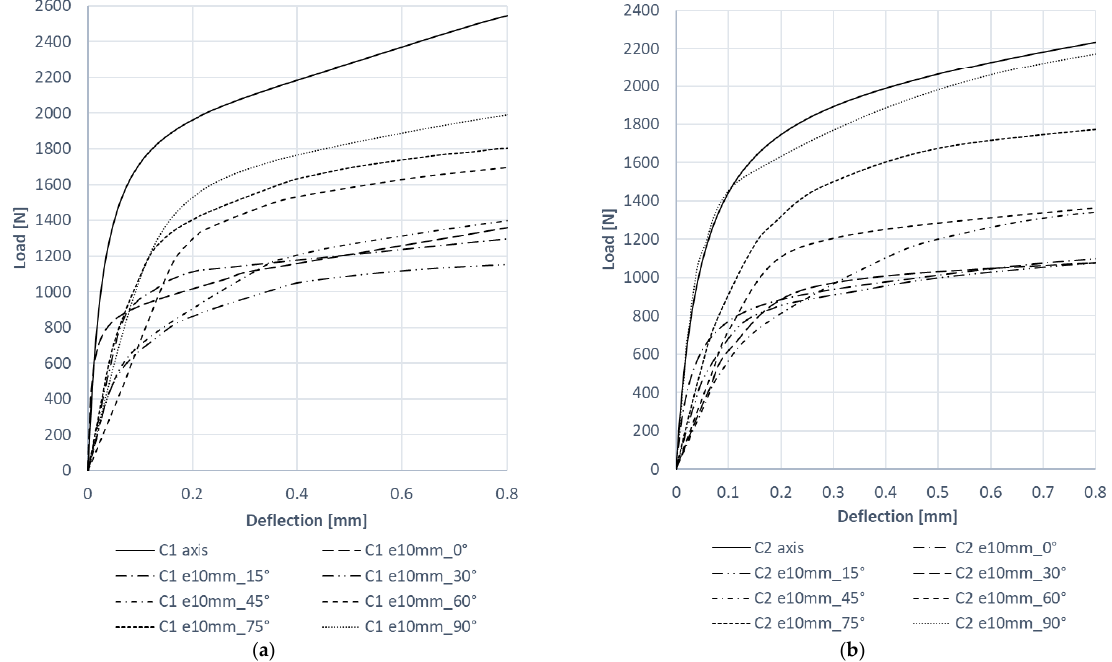
Figure 19. Load eccentricity versus postbuckling behavior for: ( a ) C1, ( b ) C2. The results demonstrate that the postbuckling stiffness of C1 and C2 decreased when eccentricity was applied. Regarding C1 (Figure 19a), the maximum decrease in the stiff- ness of this structure under eccentric load was observed for e10mm_30° and amounted to 57% (compared to the axial compression case). As for C2 (Figure 19b), the eccentricity of e10mm_0° caused the highest decrease in the column’s stiffness , of 52%. An analysis of the other cases tested demonstrated a 10% increase in the stiffness of C2 for the eccentricity value of e10mm_90°. The smallest decrease in the stiffness of eccentrically loaded C1 and C2 was observed for the eccentricity value of e10mm_90°. The high costs of producing carbon – epoxy composite profiles make tests of this type expensive. This is a major limitation for scientists who research this type of structure. It should be added that FEM modelling may be interesting for considering the progressive failure and failure processes in composites [58 – 65]. For this reason, future research direc- tions will focus on the analysis of the post-critical state in the full range of loads leading to the damage and failure of the composite structure. 5. Conclusions This study investigated the effect of compressive load eccentricity on the stability and postbuckling behavior of thin-walled composite channel columns. A combined qualita- tive and quantitative analysis of the effect of the compressive load eccentricity on critical loads and postbuckling equilibrium paths of these structures was performed. The results demonstrated that the eccentricity applied perpendicular and parallel to the web of the column did not change its buckling mode, when compared to the axial compression case. The buckling mode would only change if the eccentricity was applied simultaneously in two directions (in an angle range of 15° ÷ 75°). The weakening of the column cross-section and the change in the form of buckling was due to an increase in the additional bending state, resulting from the eccentricity of the load. The results showed that the tested ply layups had an insignificant effect on the buck- ling behavior of the columns. Fiber orientation had a negligible effect on the critical load.